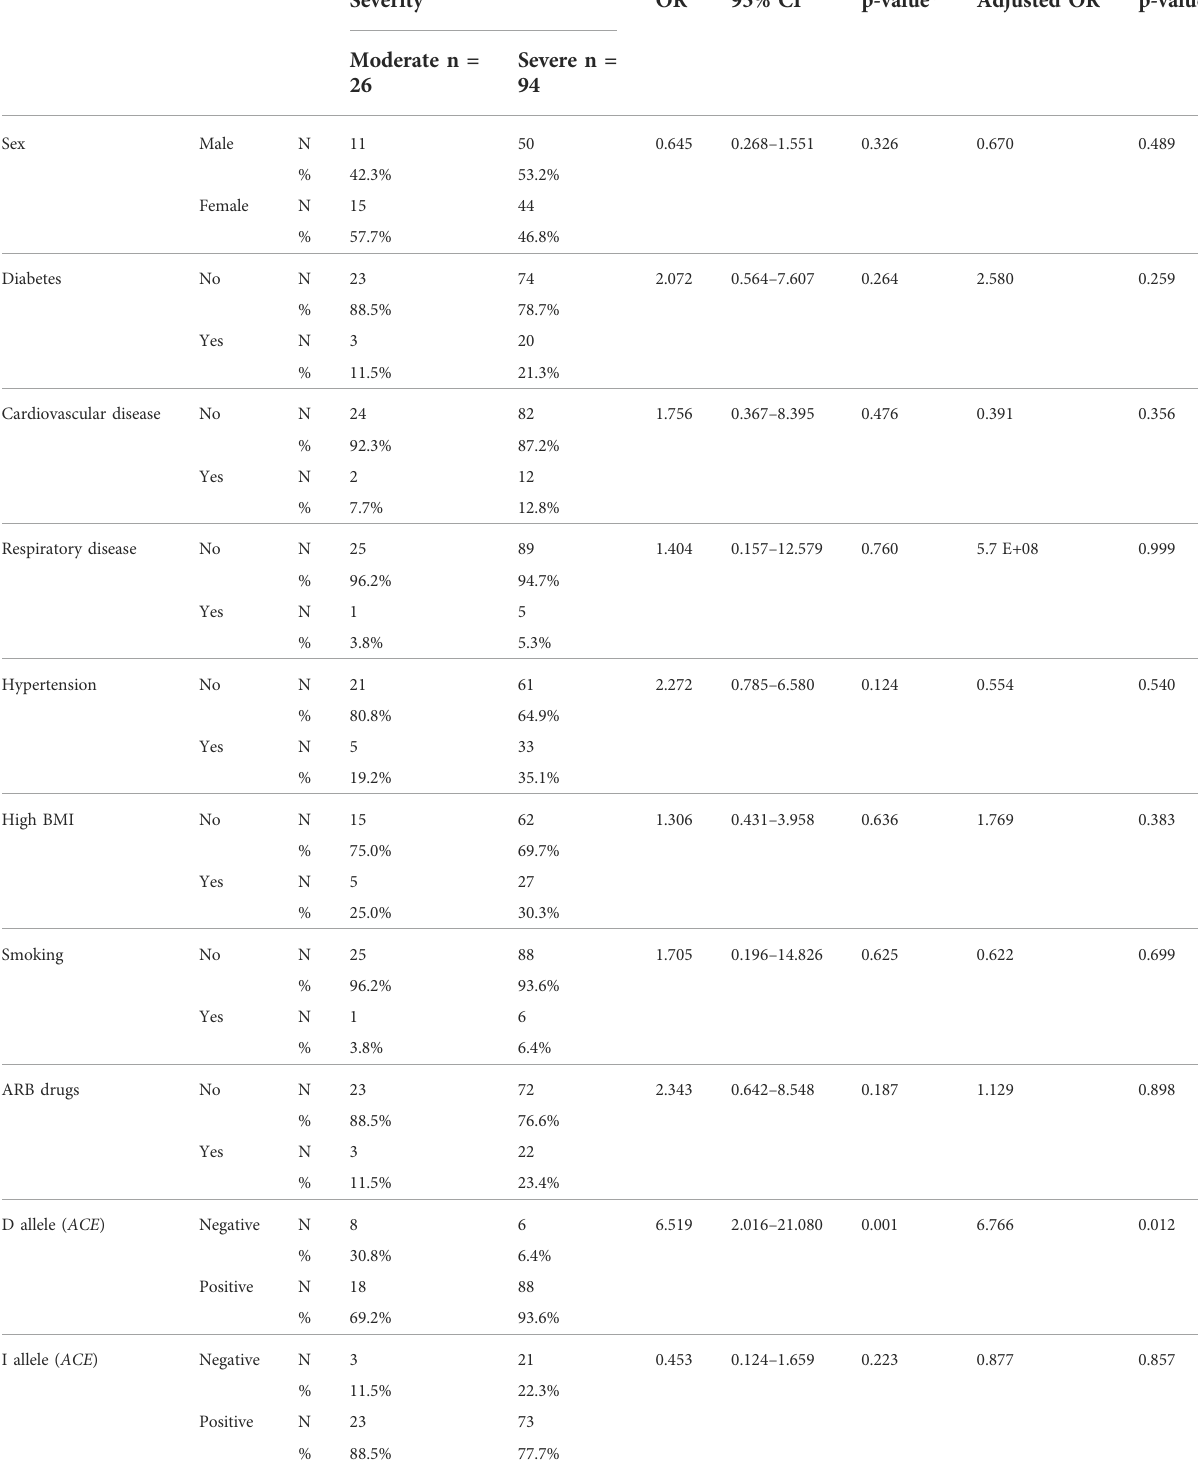
TABLE 1 Distribution of COVID-19 patients parameters based on disease severity. Adjusted odds ratio was calculated based on binary logistic regression analysis. Severity OR 95%